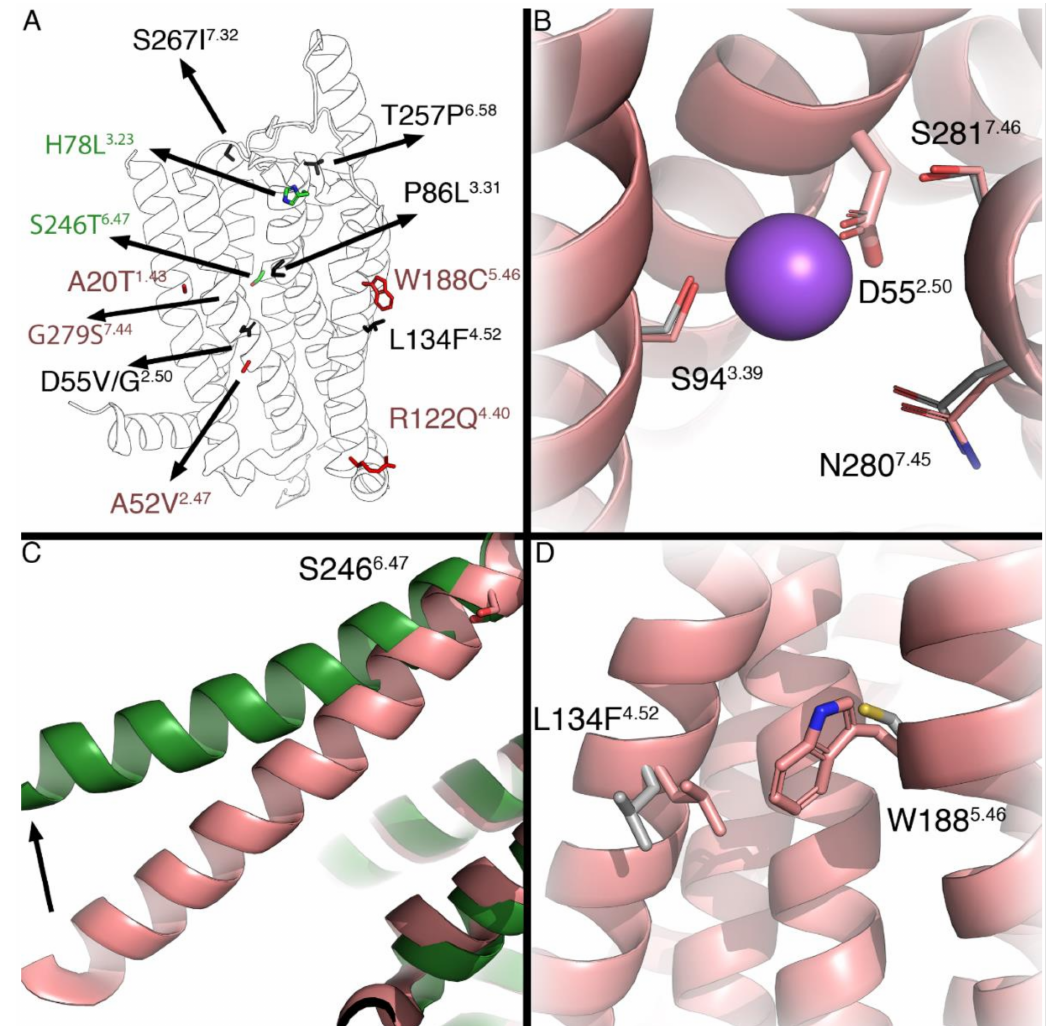
Figure 6. ( A ) Overview of all mutations mapped on the X-ray structure of the hA 1 AR, inactive (5UEN) in red and active (6D9H) in green. Residues are colored by their observed effect, CAMs in green, CIMs in red, and LFMs in black. ( B ) Close up of residue D55 2.50 . In grey, residues are found in the A 2A AR binding site, with the sodium ion from that structure (PDB: 4EIY) in purple. ( C ) Residue S246 6.47 is found near the hinging region of TM6, the outward motion of which is associated with receptor activation (shown with arrow). ( D ) Residues L134 4.52 and W188 5.46 form a cluster and are pointing toward the